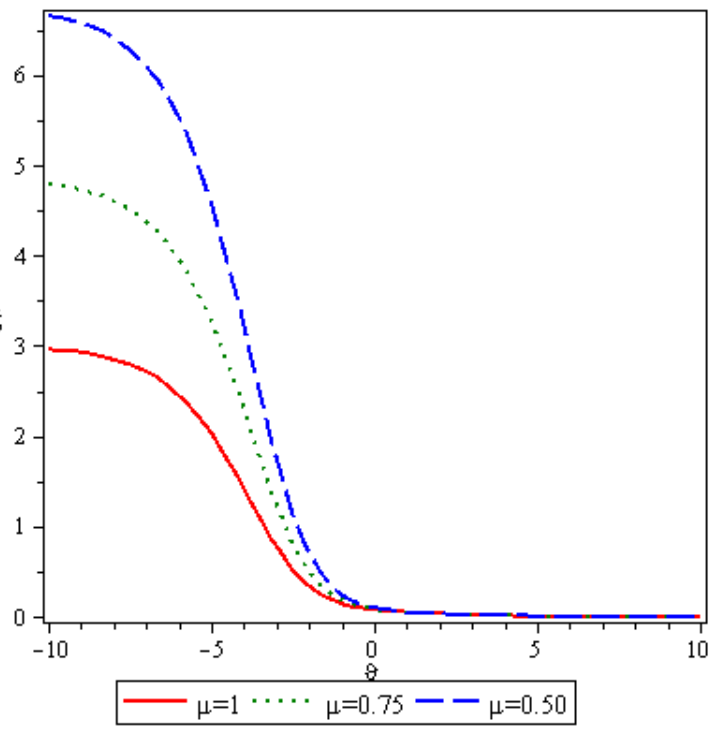
Figure 17. Response of q -HAGTM solution ξ ( ϑ , θ ) for AC Equation (54) for different values of fractional order µ at θ = 1 .